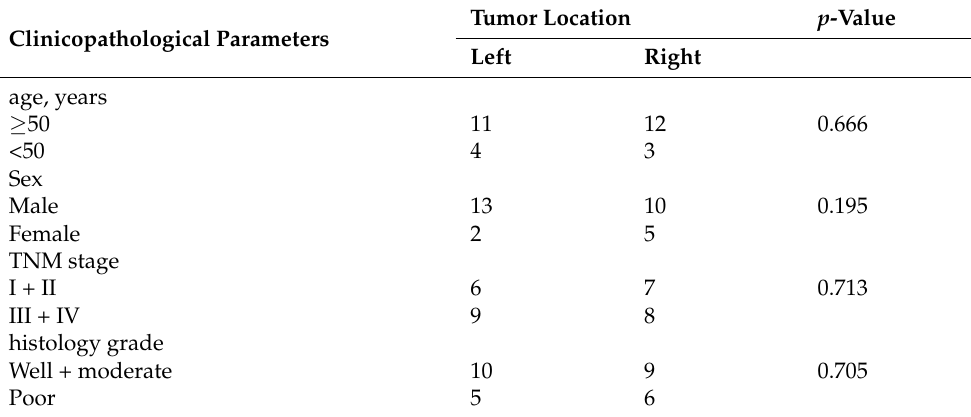
Table 1. Clinicopathological characteristics in colon cancer